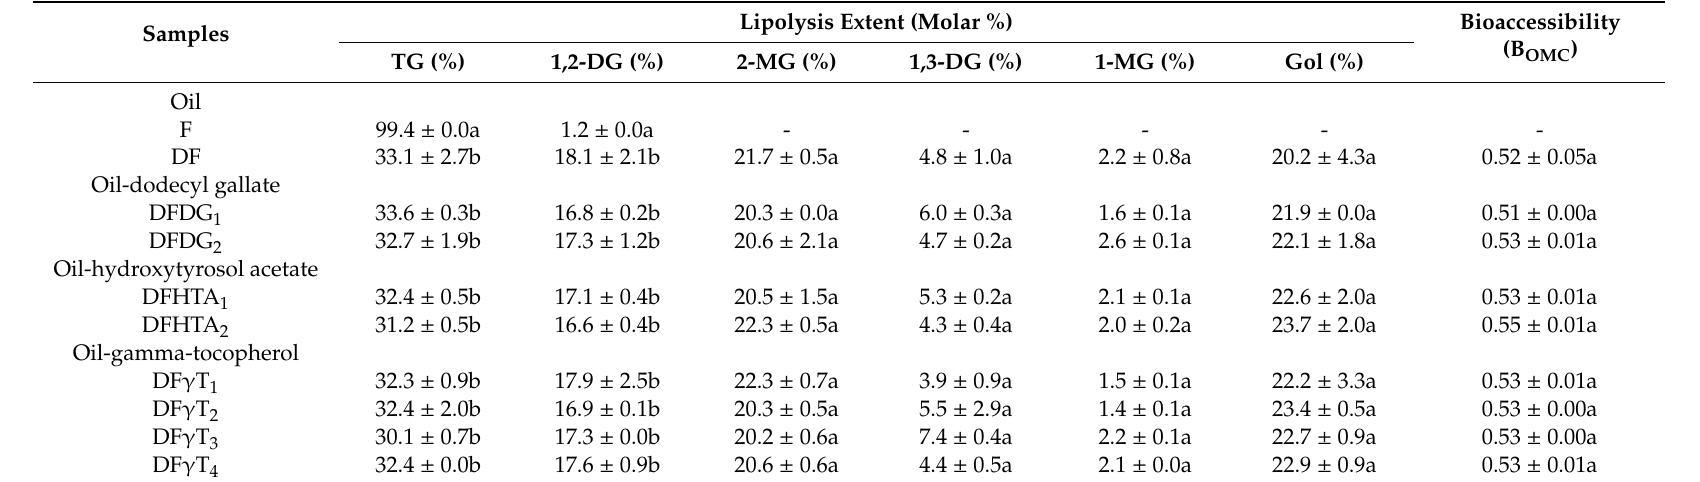
Di ff erent letters within each column indicate a statistically significant di ff erence among the samples ( p < 0.05). A dash indicates “not